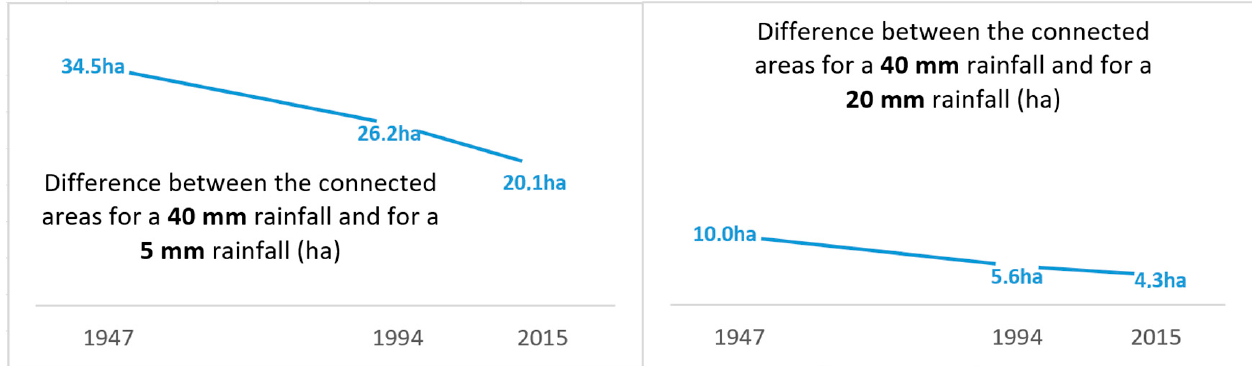
Figure 11. Evolution of connected areas.